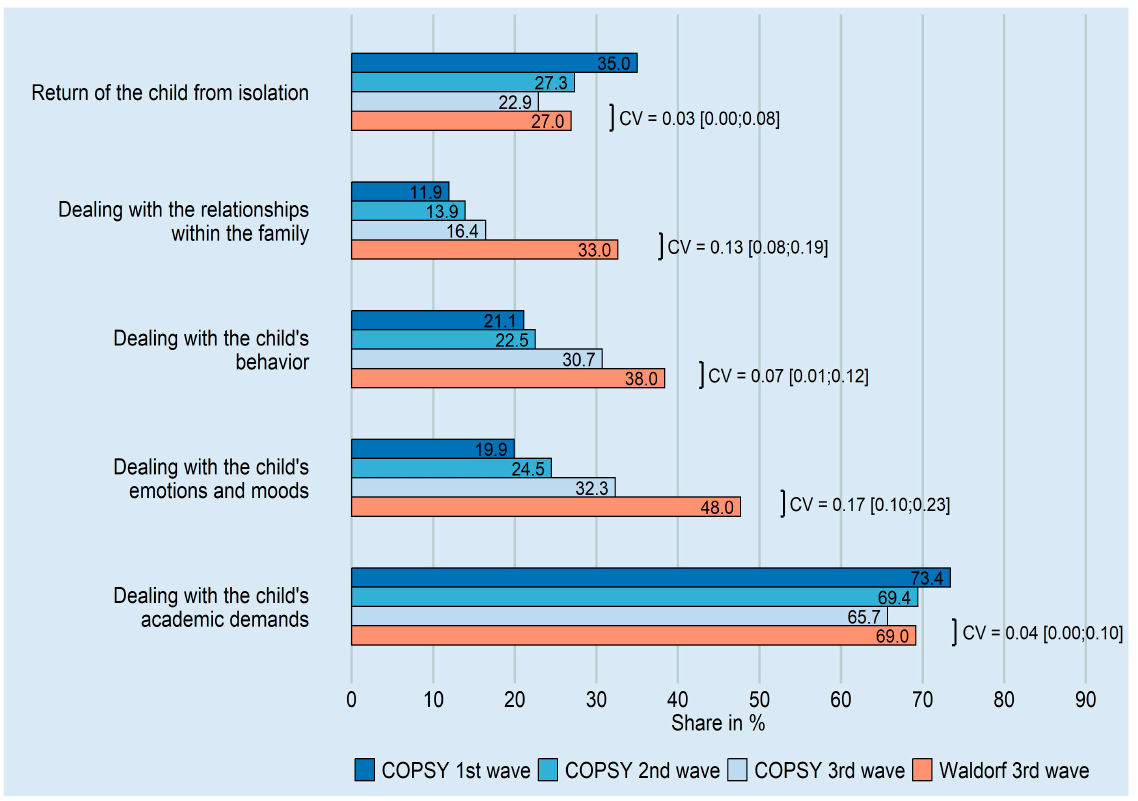
Figure 1. Support needs of Waldorf parents in dealing with their children during the third COVID- 19 wave compared to the COPSY sample (first, second, and third wave) [4,20,21]. Multiple responses were allowed. Indicated is the share of parents who indicated that they always/rather often/occasionally needed support (Waldorf sample: n = 279). Cramér’s V (CV) and its confidence interval were used to compare the support needs of the Waldorf and COPSY samples during the third wave.